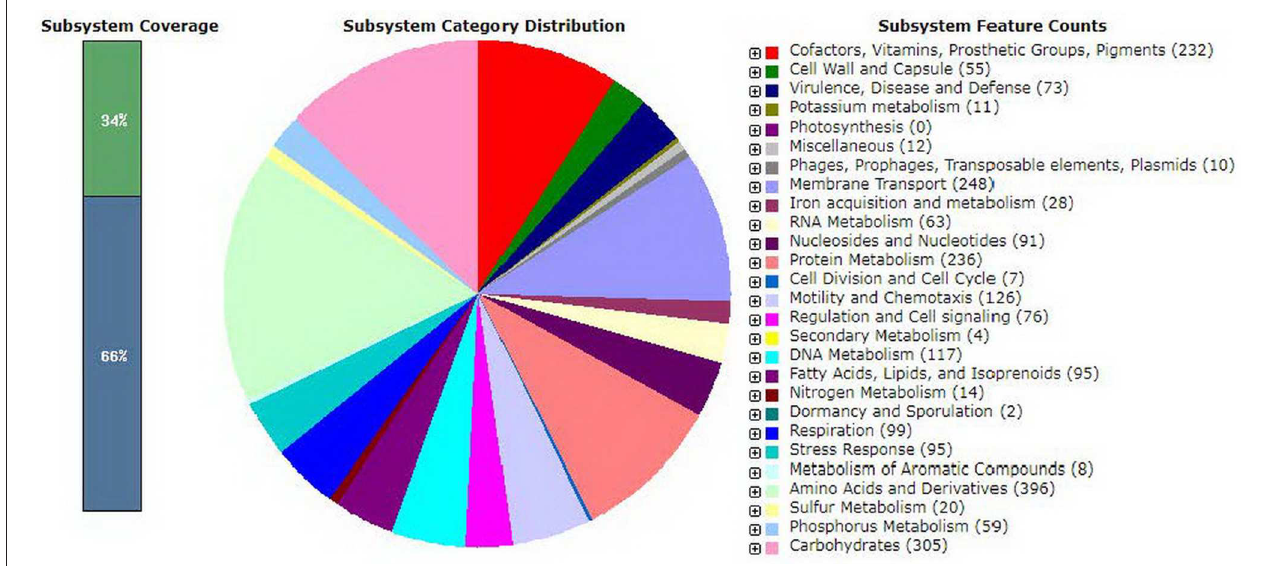
FIGURE 1 | Subsystem category distribution of V. parahaemolyticus 2HP (results of RASTtk annotation). Subsystem coverage shows sets of functional roles in specific biological processes (green box) and non-specific processes (blue box). Overall genome annotation is represented in a pie chart of subsystem category distribution. Different colors in pie chart explain details and numbers of genes in subsystem feature